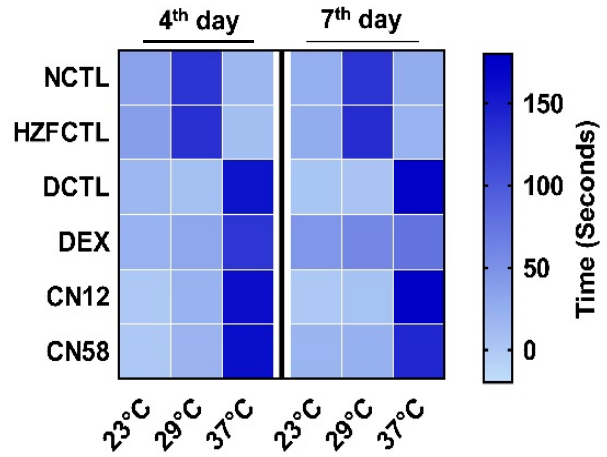
Figure 3. Coronil reduces SARS-CoV-2 spike protein induced behavioral fever. Heat map of time spent (in seconds) at the set temperatures (low temperature 23 °C, normal temperature 29 °C, and behavioral fever 37 °C) by the zebrafish from various groups on the fourth and seventh day time points. Color intensity indicates the time spent at the particular temperature chamber. SARS-CoV-2 spike protein induced behavioral fever was decreased in a dose dependent manner upon CN treatment at the seventh day time point.